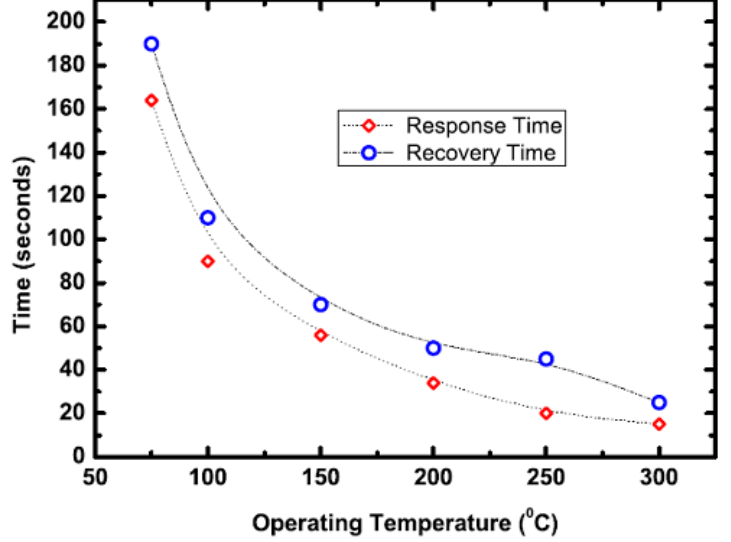
Figure 6. The response and recovery times of the Pd-modified WO 500 ppm hydrogen as a function of operating